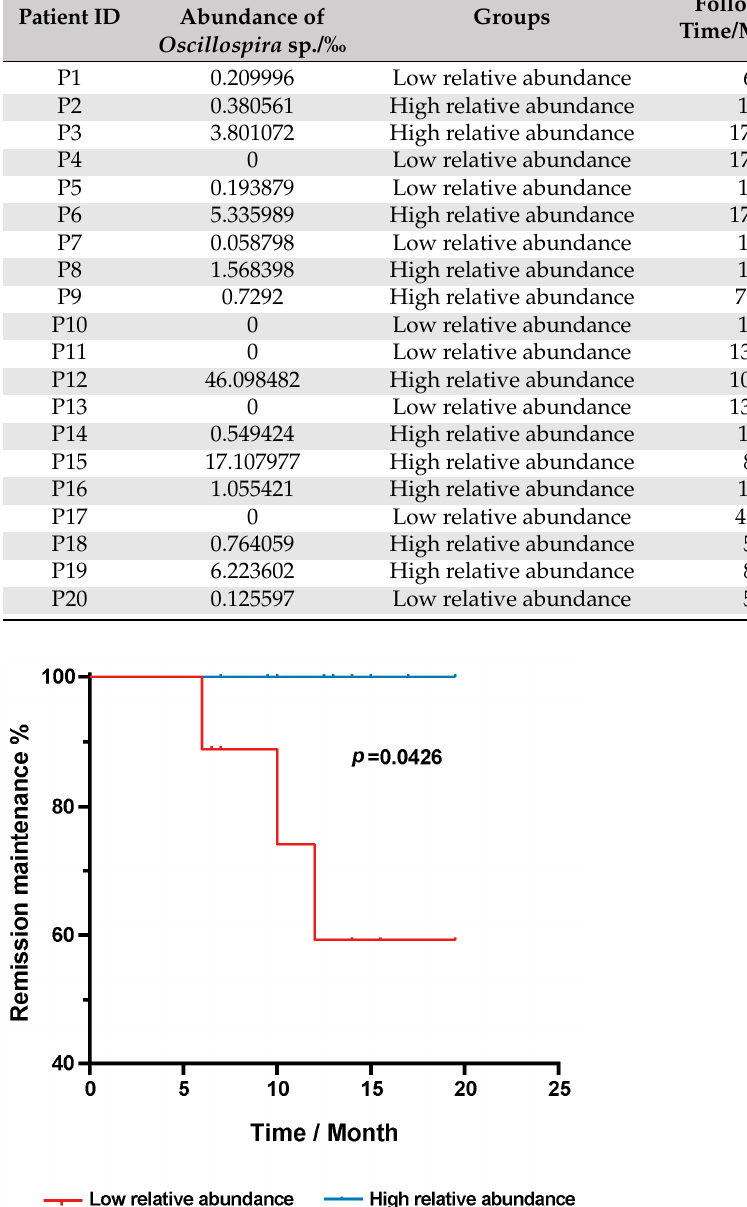
Figure 5. Kaplan-Meier’s curve showed the proportion of CD patients without disease recurrence over post-operative time. Comparison was conducted between patients with high and low abundance of mucosa-associated Oscillospira sp. in the residual segments.